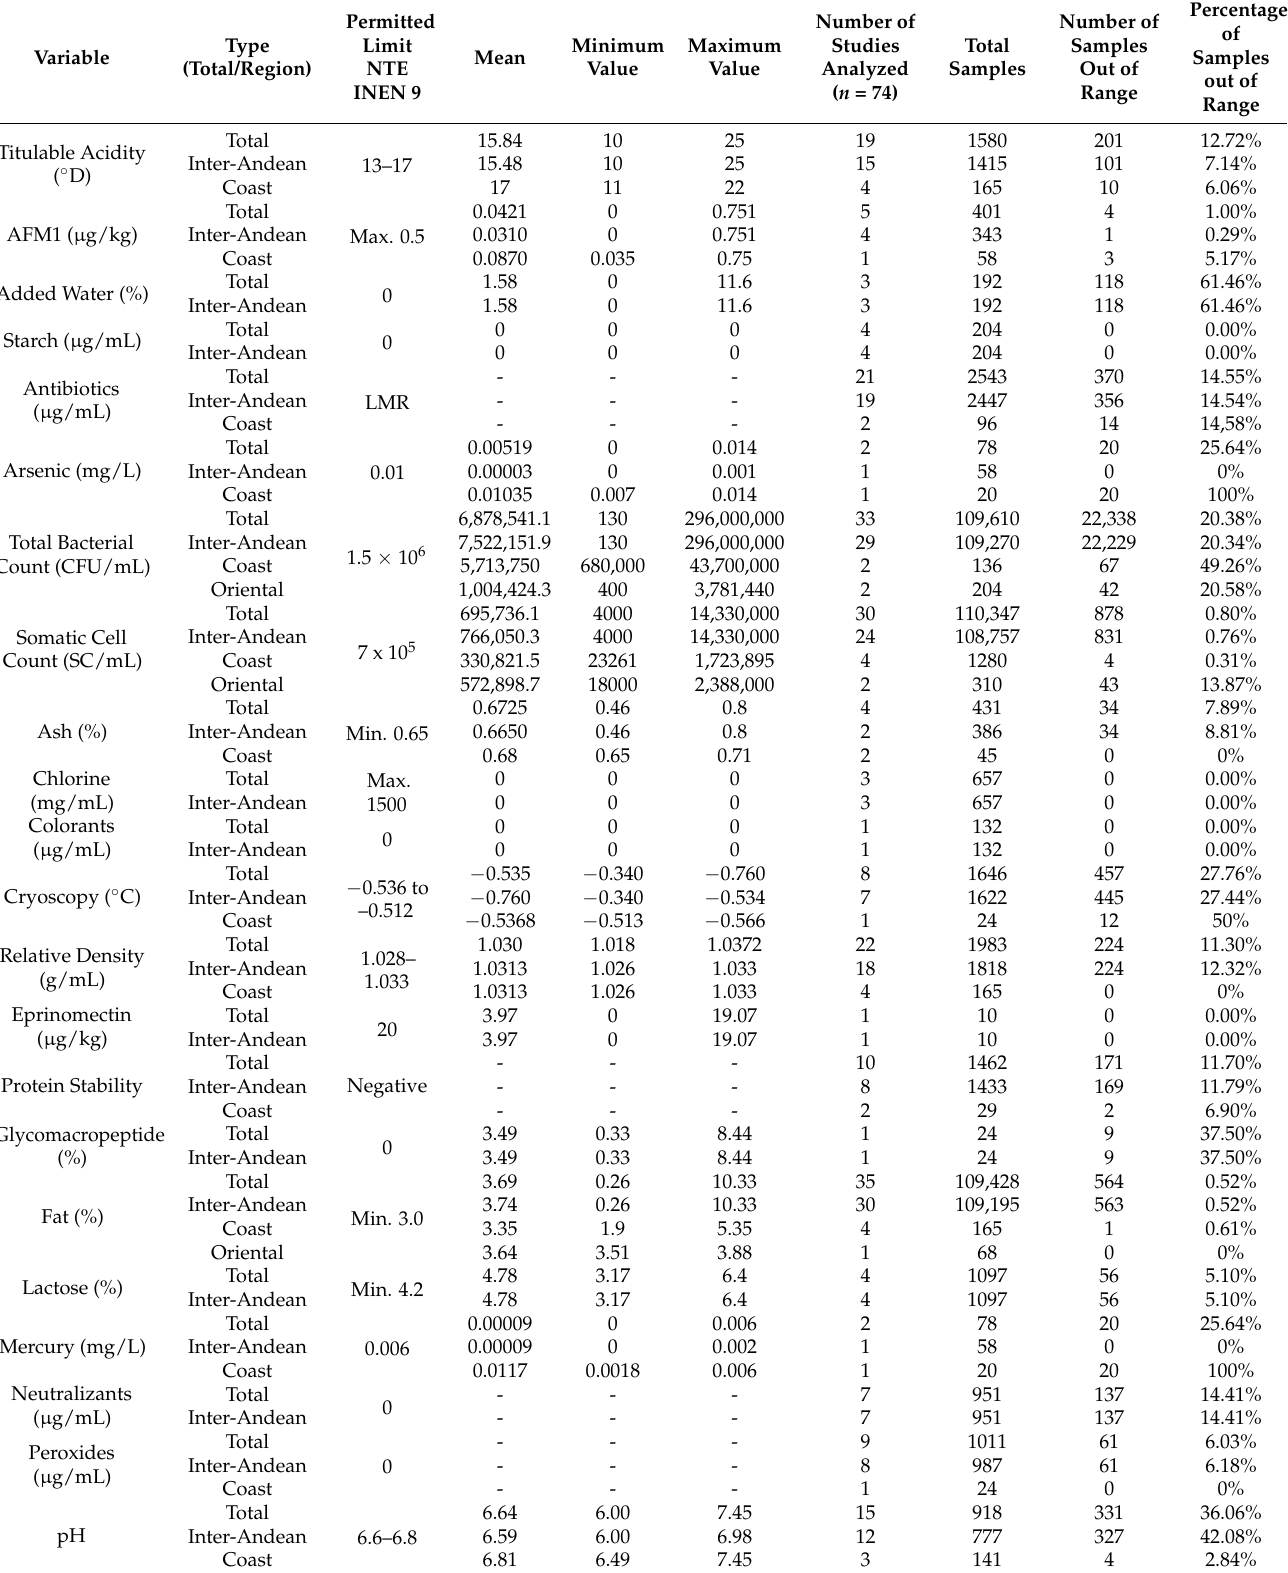
Table 1. Allowable limits, measures of central tendency, studies analyzed and % compliance of the variables used in the